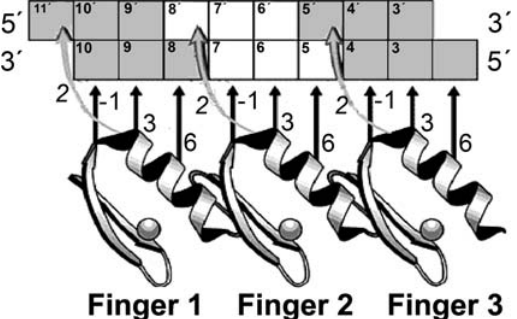
Figure 1. The Canonical Cys 2 His 2 Zinc Finger DNA Binding Model Residues at positions 6, 3, 2, and (cid:1) 1 (relative to the beginning of the a - helix) at each finger interact with adjacent nucleotides in the DNA molecule (interactions shown with arrows). (Figure adapted from a figure by Prof. Aaron Klug, with permission.) DOI: